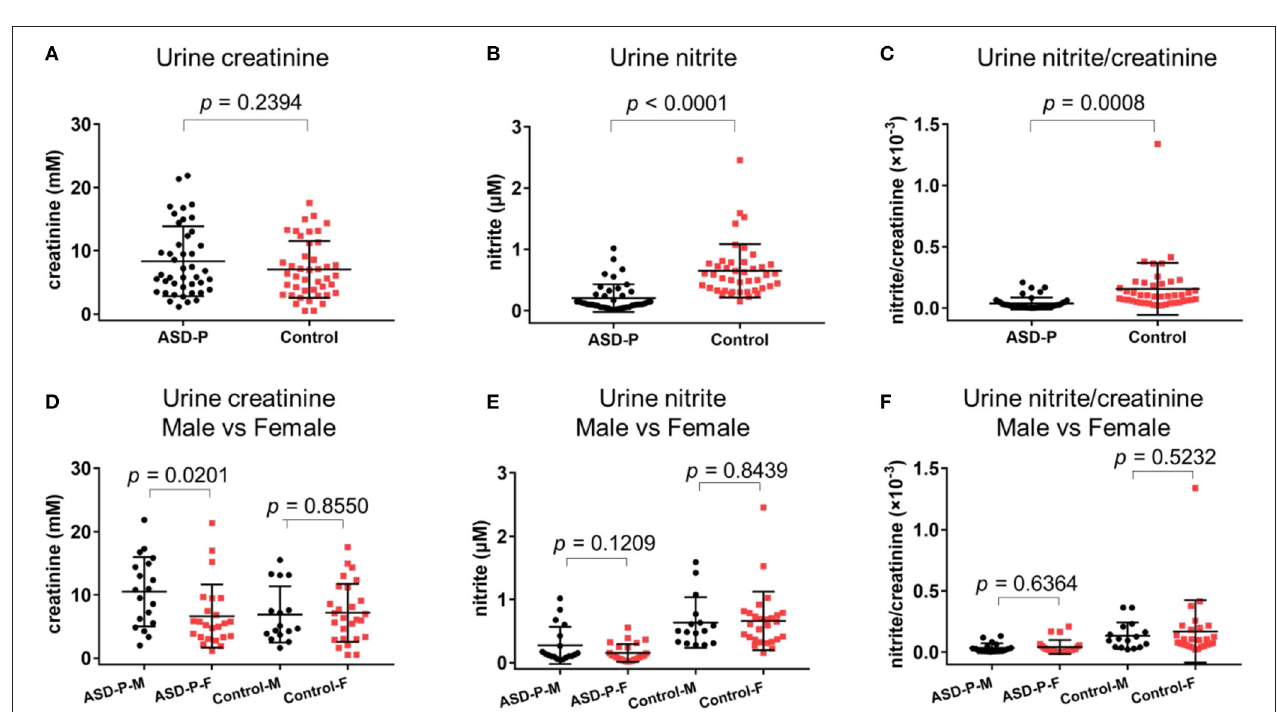
FIGURE 1 | Levels of urine creatinine, nitrite, nitrite/creatinine in the ASD-P and Control groups. (A) creatinine concentrations in two groups. (B) nitrite concentrations in two groups. (C) nitrite/creatinine levels in two groups. (D) creatinine concentrations for male and female participants. (E) nitrite concentrations for male and female participants. (F) nitrite/creatinine levels for male and female